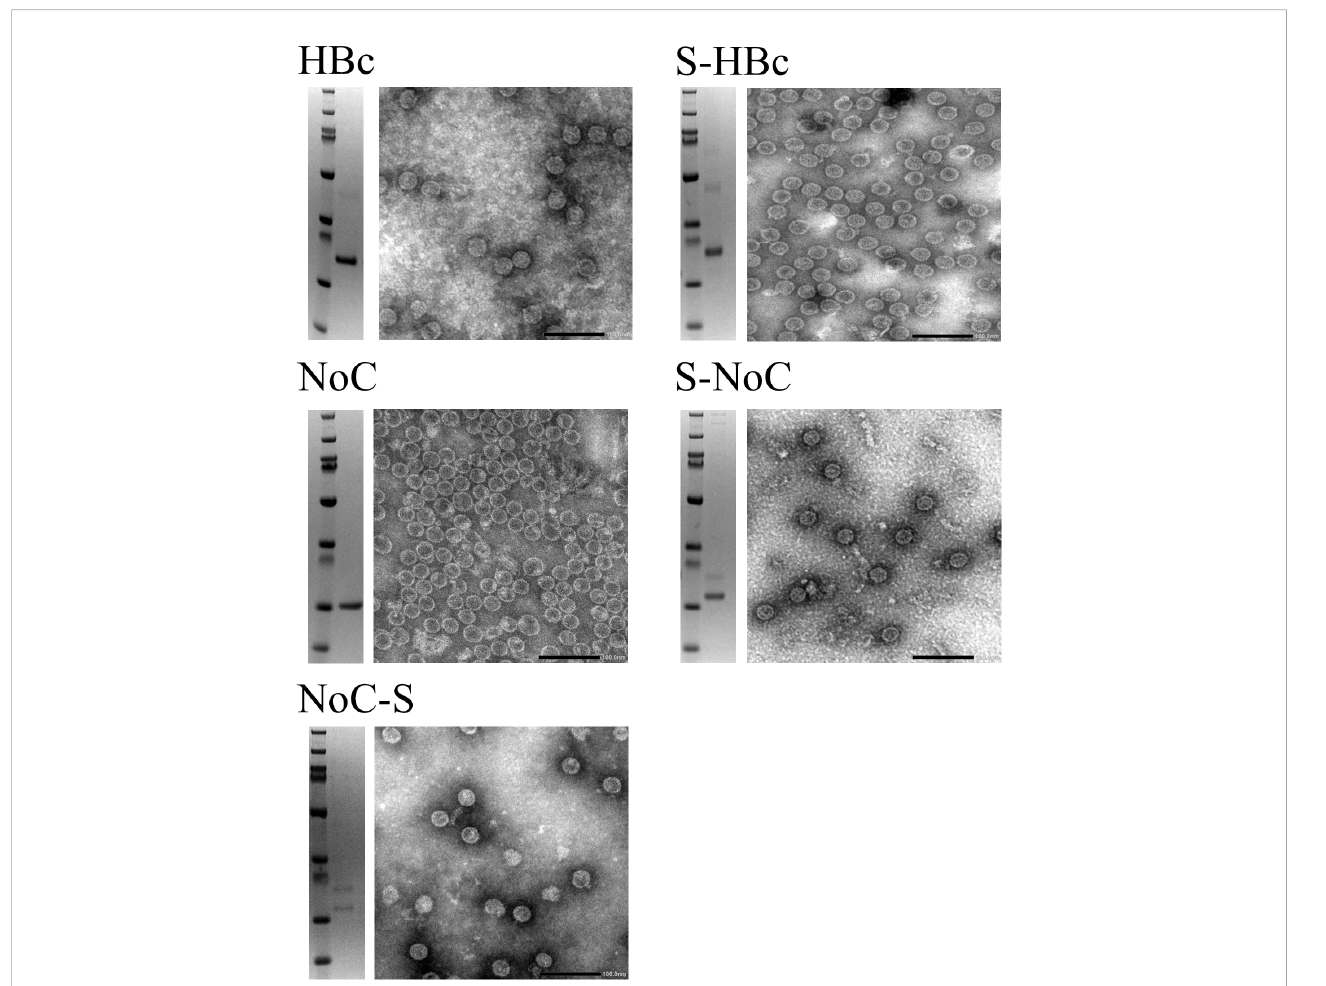
FIGURE 4 Transmission electron microscopy of HBc VLP constructs produced in BYL. The SDS-PAGE result after puri fi cation is shown on the left of each panel, and the corresponding TEM to the right for the different HBc VLP constructs. HBc, hepatitis-B core antigen; NoC, HBc core antigen lacking the C- terminal domain; S, Strep insert, located either at N-terminus or spike of the HBc and NoC